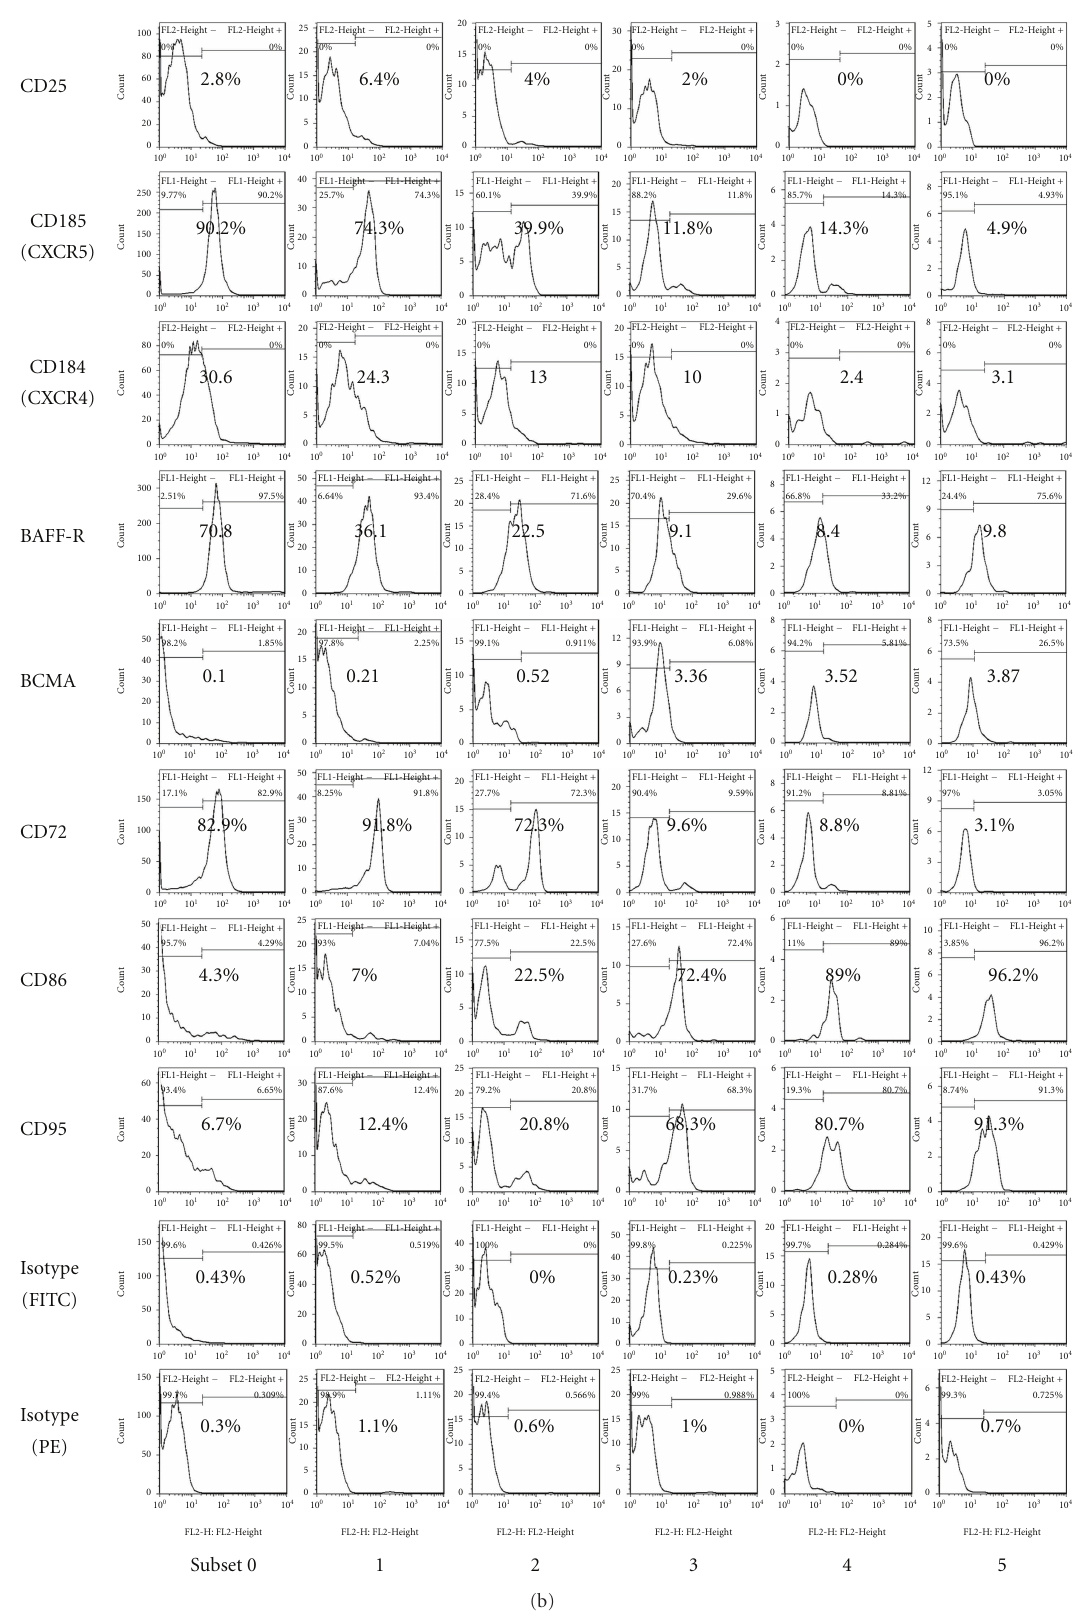
Figure 2: Flow cytometric analysis of various antigens on and in B cell subsets from a patient with SLE. Positive cell ratio or MFI (mean fluorescence intensity) was shown in flow cytometric